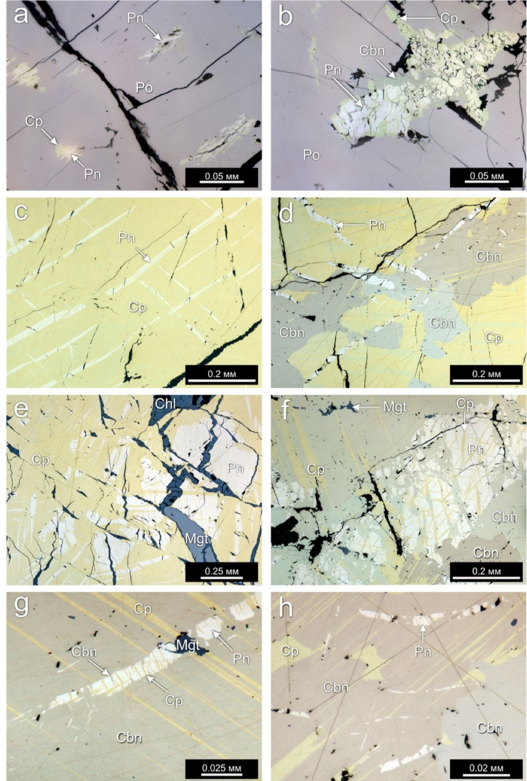
Figure 4. Morphological varieties of pentlandite from the ores of EM-7 borehole: ( a ) Flames in pyrrhotite ores; ( b ) Granular pentlandite in pyrrhotite ores; ( c ) Network of pentlandite lamellae in chalcopyrite ores; ( d ) Network of partially dissolved pentlandite lamellae in cubanite ores; ( e ) Granu- lar pentlandite in chalcopyrite ores; ( f ) Granular pentlandite in cubanite ores; ( g ) Pentlandite lamellae in cubanite ores with the network of chalcopyrite lamellae inside; ( h ) Relict of the network of pent- landite lamellae in cubanite ores. Reflected light, nicols are not completely crossed.